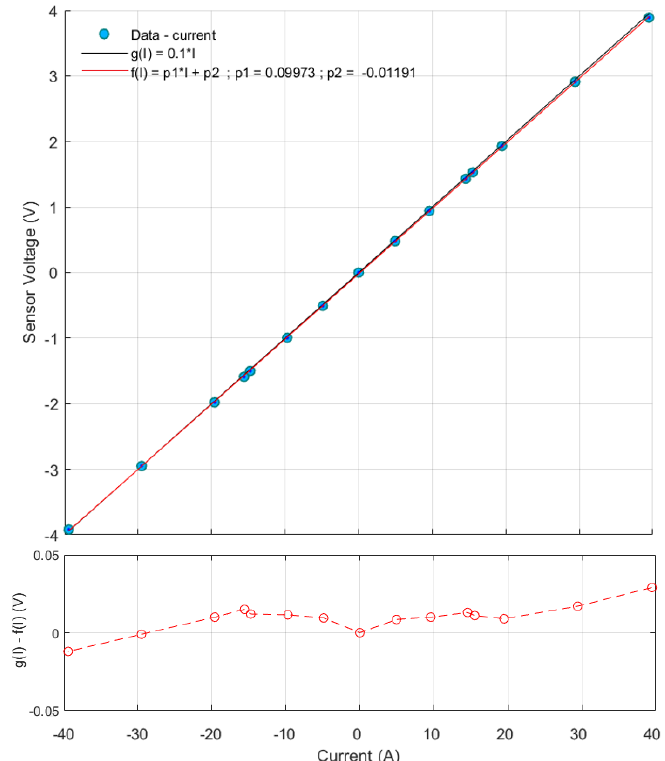
Figure 5. ALCS sensor output voltage (V) in the function of the measured current (A). The difference between the theoretical and the practical chart does not exceed 0.03 V.